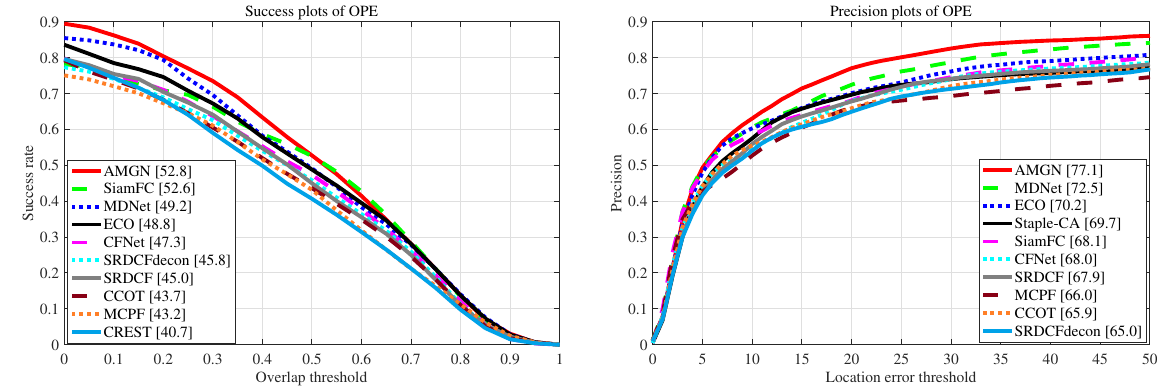
Figure 9. Success and precision plots on the UAVDT dataset using one-pass